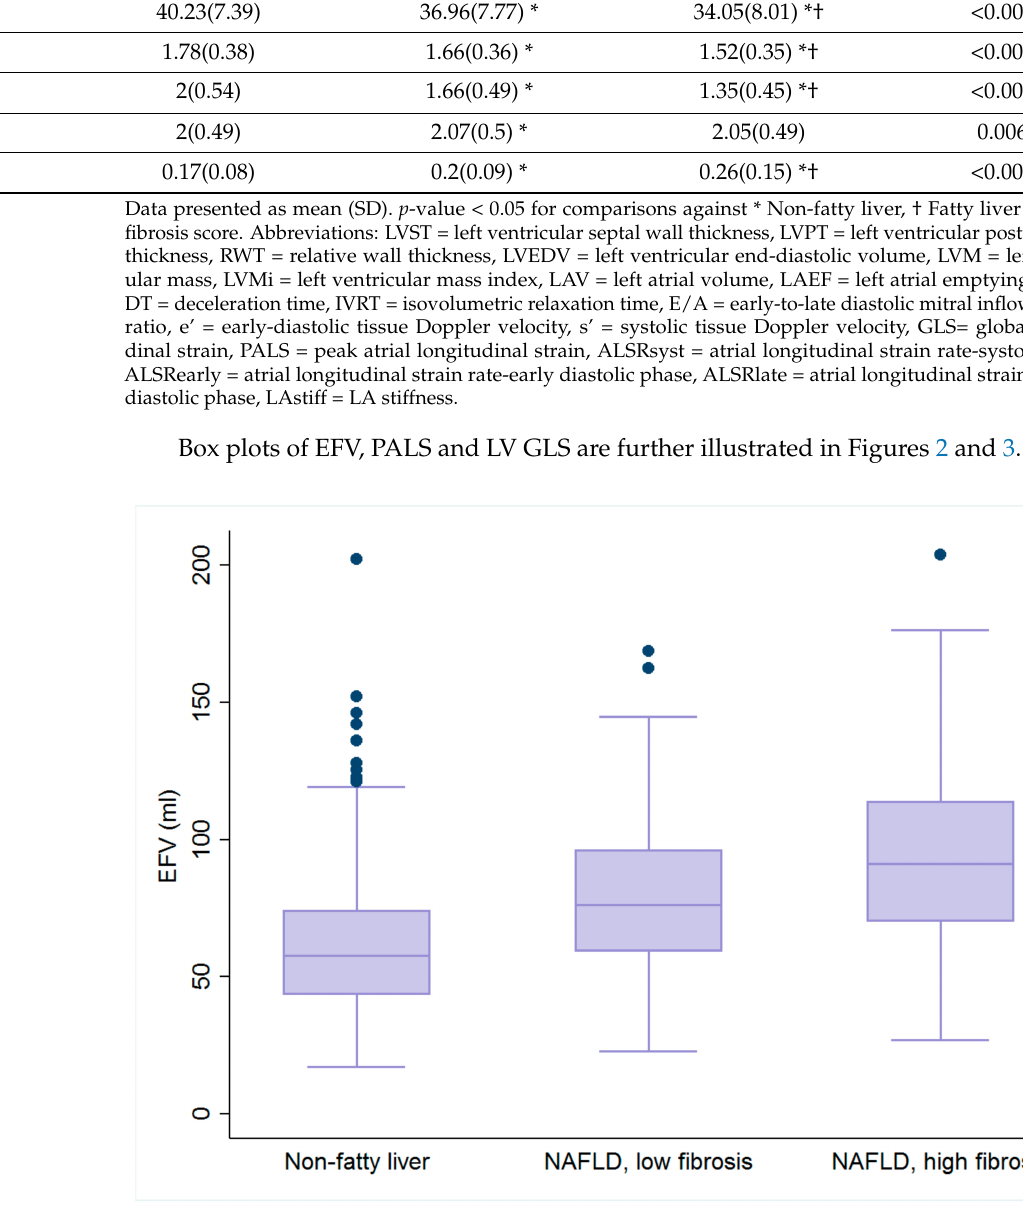
Figure 2. Box plots of epicardial fat volume (EFV). Graded increases in EFV were observed across all three groups (all p <